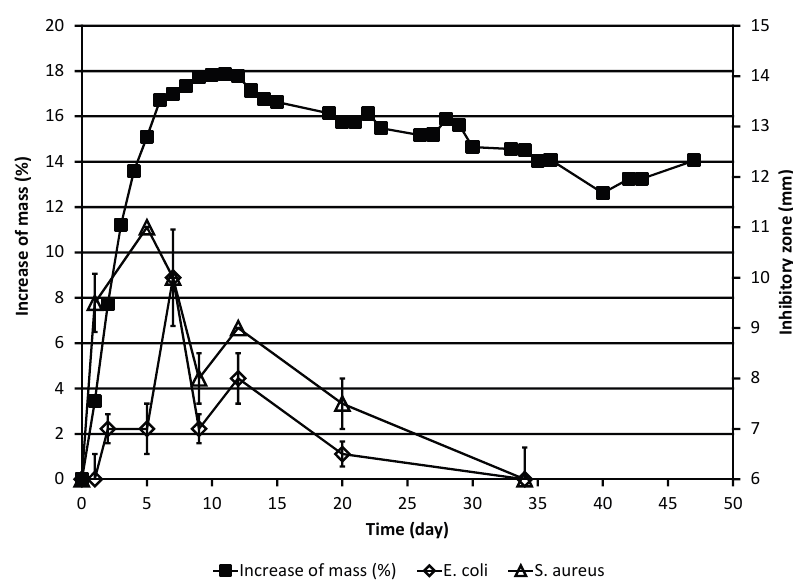
Figure 2. Increase of the corrected mass of the ML sample during the autoxidation process, as compared to the original mass, and the results of simultaneous determinations of inhibitory zones against the bacteria E. coli and S. aureus . The corrected mass of the ML was calculated using Equation (1). In cases where no error bar is shown for the inhibitory zone value, the standard deviation was